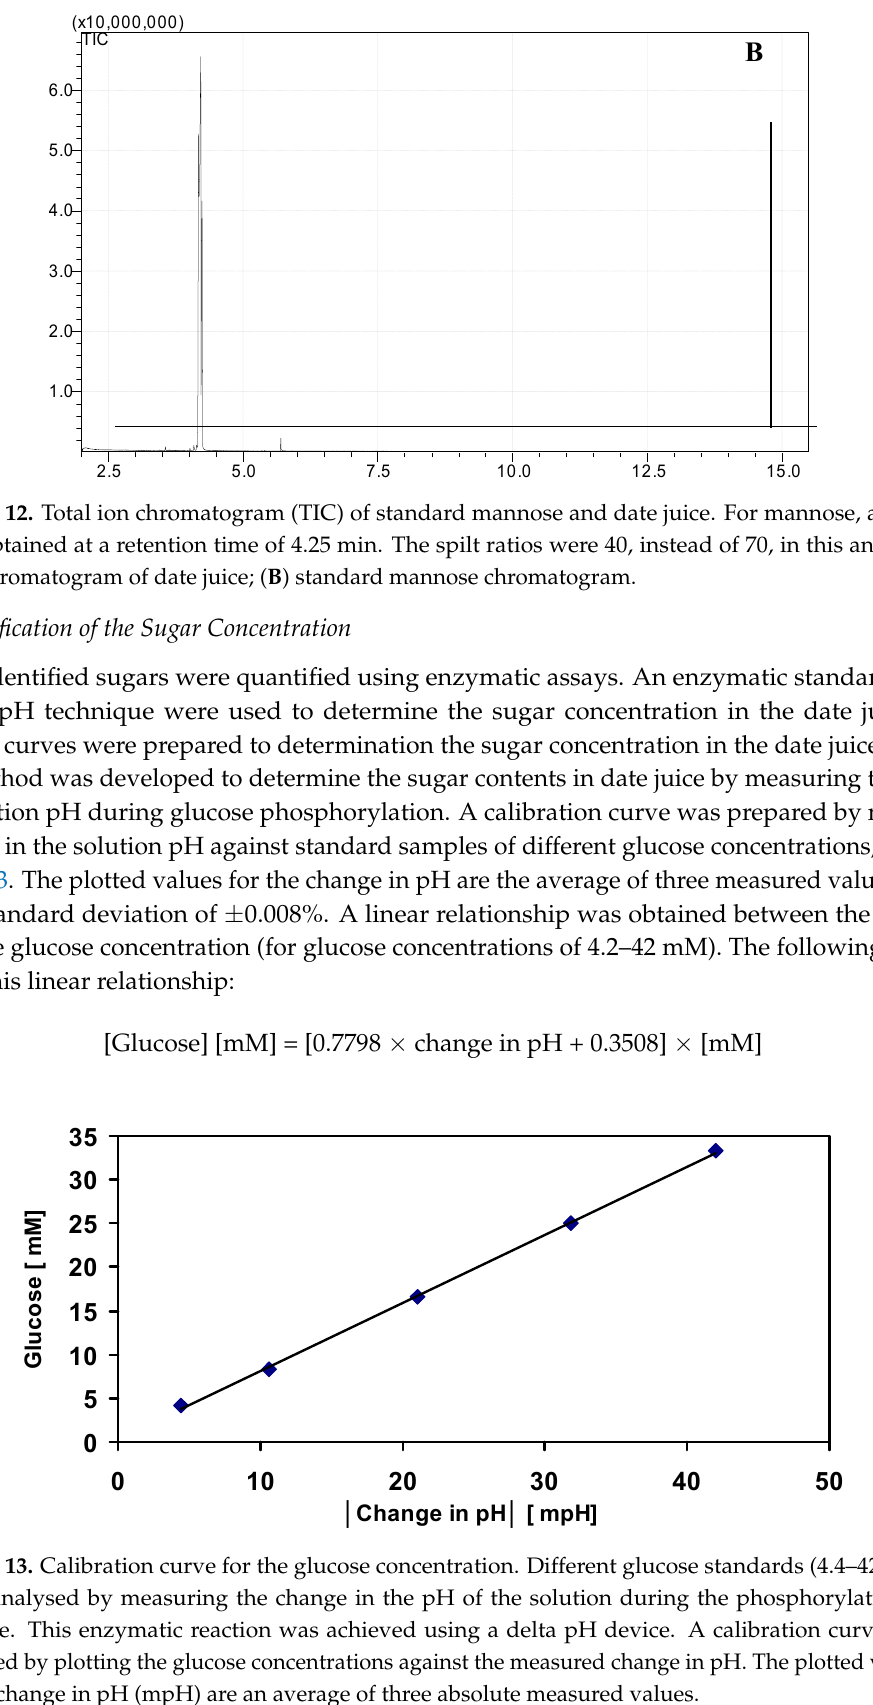
of the change in pH (mpH) are an average of three absolute measured